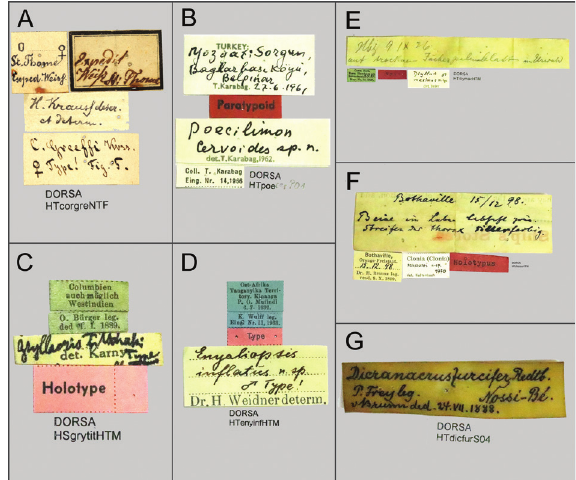
Figure 2. Typical labels of several important taxonomists, who de- posited material in the collection: A: Hermann Krauss, B: Tevfik Karabag, C: Heinrich Hugo Karny, D: Herbert Weidner, E: Max Beier, F: Alfred Kaltenbach, G: Josef